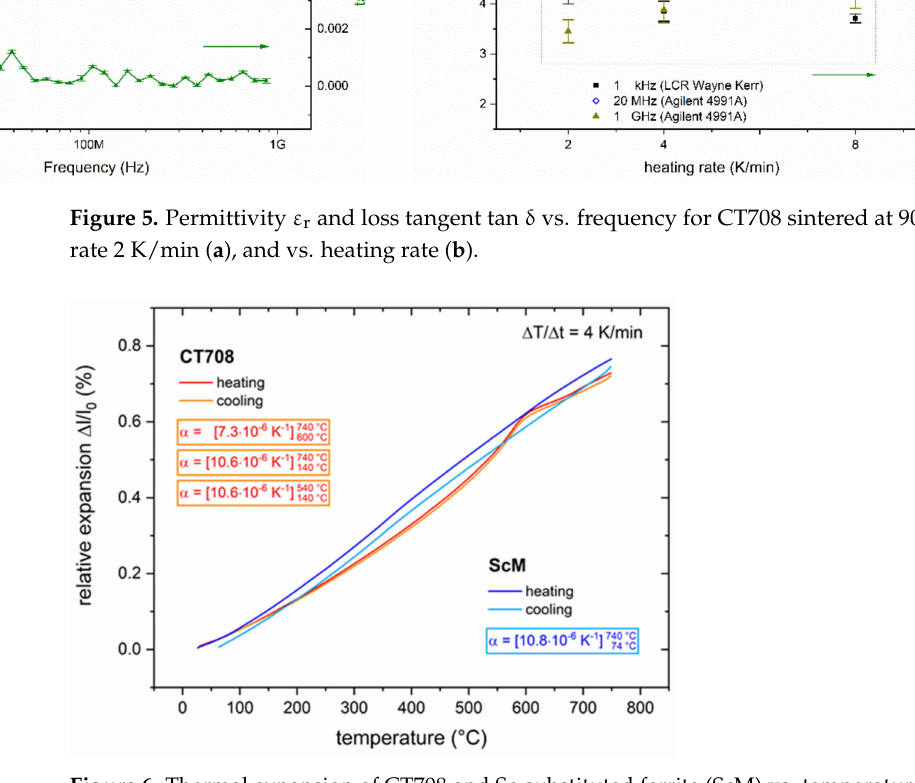
Figure 6. Thermal expansion of CT708 and Sc-substituted ferrite (ScM) vs. temperature (heating and cooling runs, heating rate 4